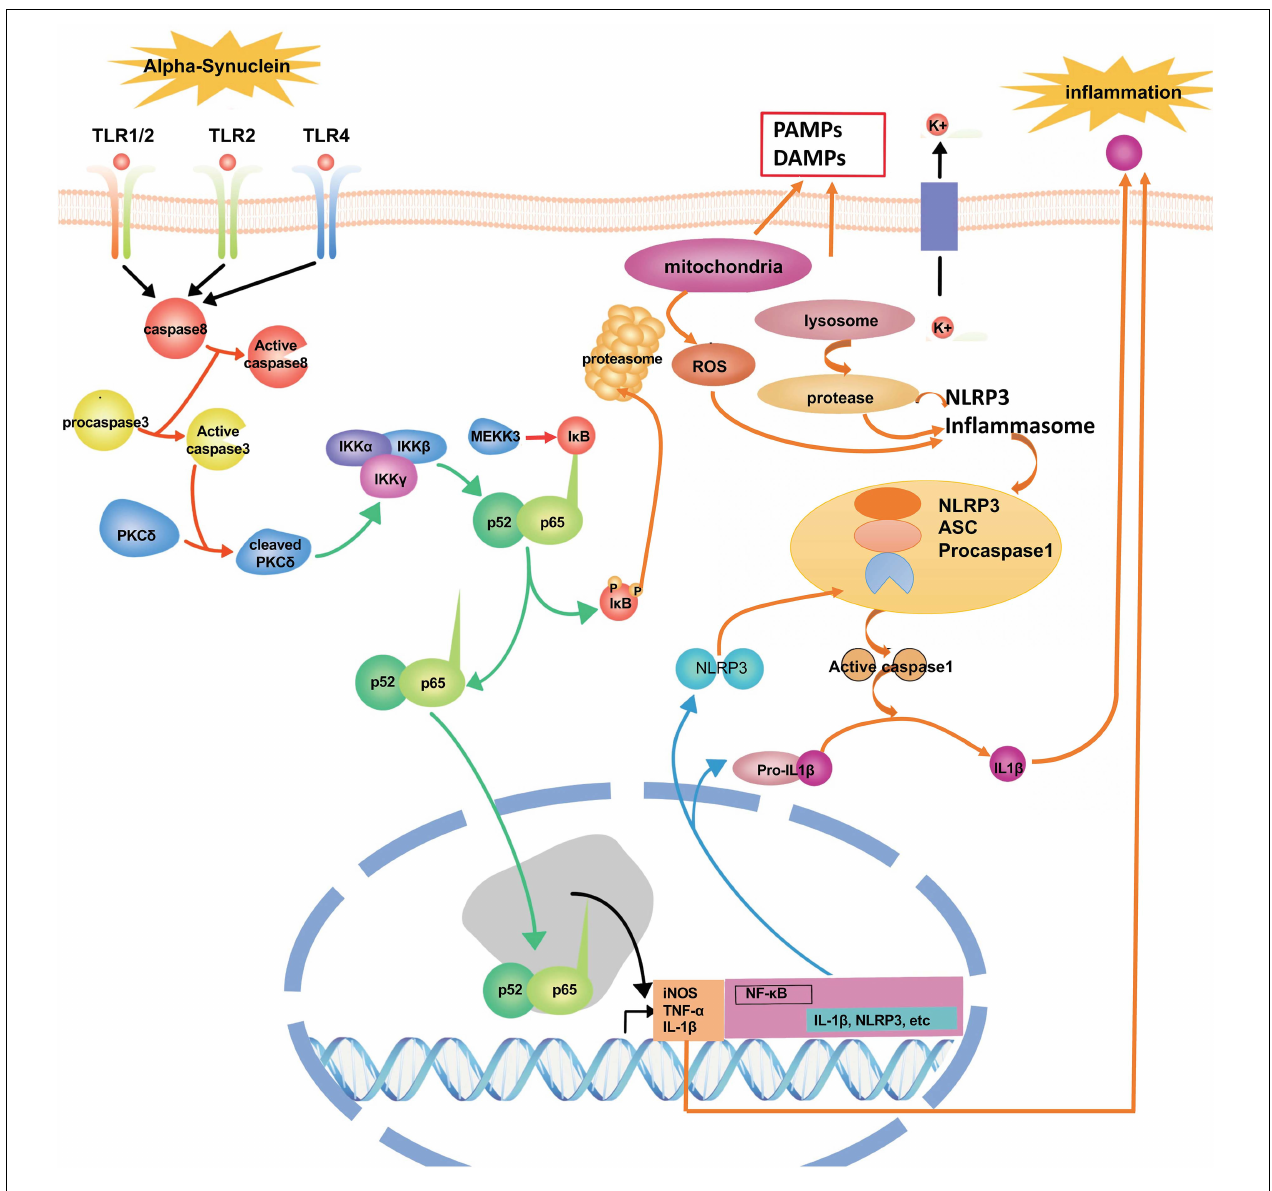
FIGURE 3 | The signaling pathways and molecular factors involved in neuroinflammation. α -syn together with inflammasome form a network to regulate the activation of microglia. Blocking these signaling pathways and molecular factors can effectively improve apoptosis or the death of dopamine neurons caused by